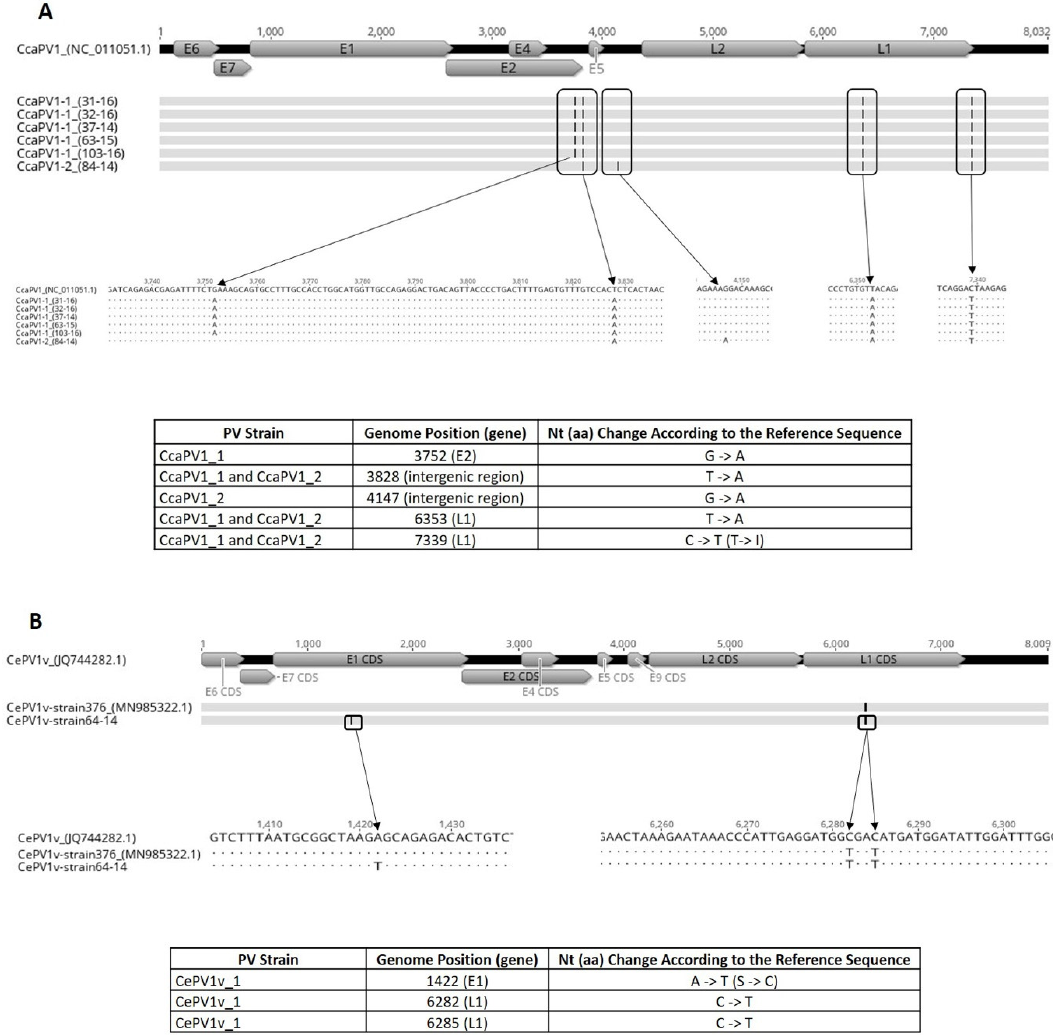
Figure 3. Multiple alignments of roe ( A ) and red deer ( B ) PV genomes from this study compared to the reference CcaPV1 genome and CePV1v genomes, respectively, highlighting the distribution of nucleotide substitutions, which are described in detail in the tables. Nt: nucleotide, aa: amino acid. Table 2. Results of the whole-genome sequencing of the PV genomes and the assembly statistics. PV Strain Total Reads Mapped Reads Mean Read Length CcaPV1-1 (31-16)